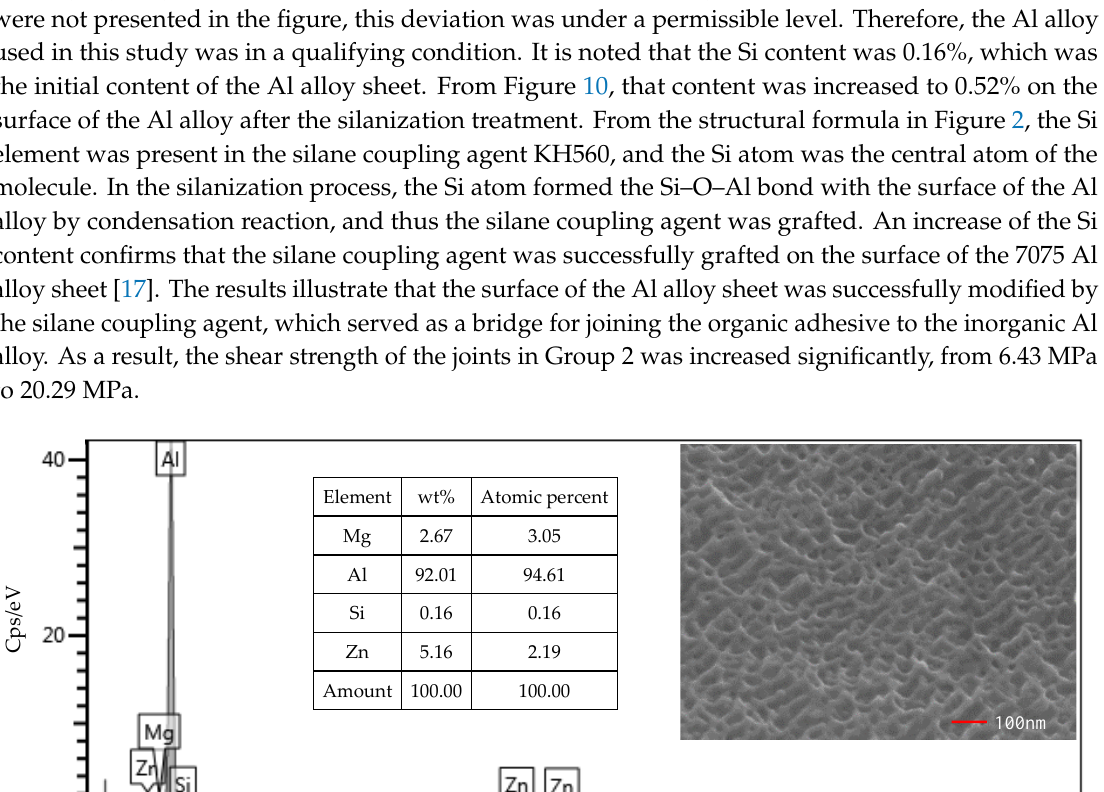
100.00 Figure 10. SEM and EDS test of the surface of the Al alloy sheet after the silanization treatment. The surface morphology of the Al alloy sheet after the alkaline cleaning and acid pickling is shown in Figure 9. From the figure, small pits with the length of about 100 nm were etched on the surface. After the silanization treatment, the surface was much rougher, and grooves with the length of about 200 nm were produced, as shown in Figure 10. It can be seen that the surface was further etched in the silanization treatment. This can be attributed to the silane coupling agent solution, which was acidic. The solution was a mixture of methanol, distilled water, and KH560 with the volume ratio of 96:3:1, and its pH value was adjusted to 5 with acetic acid. The acidic solution was